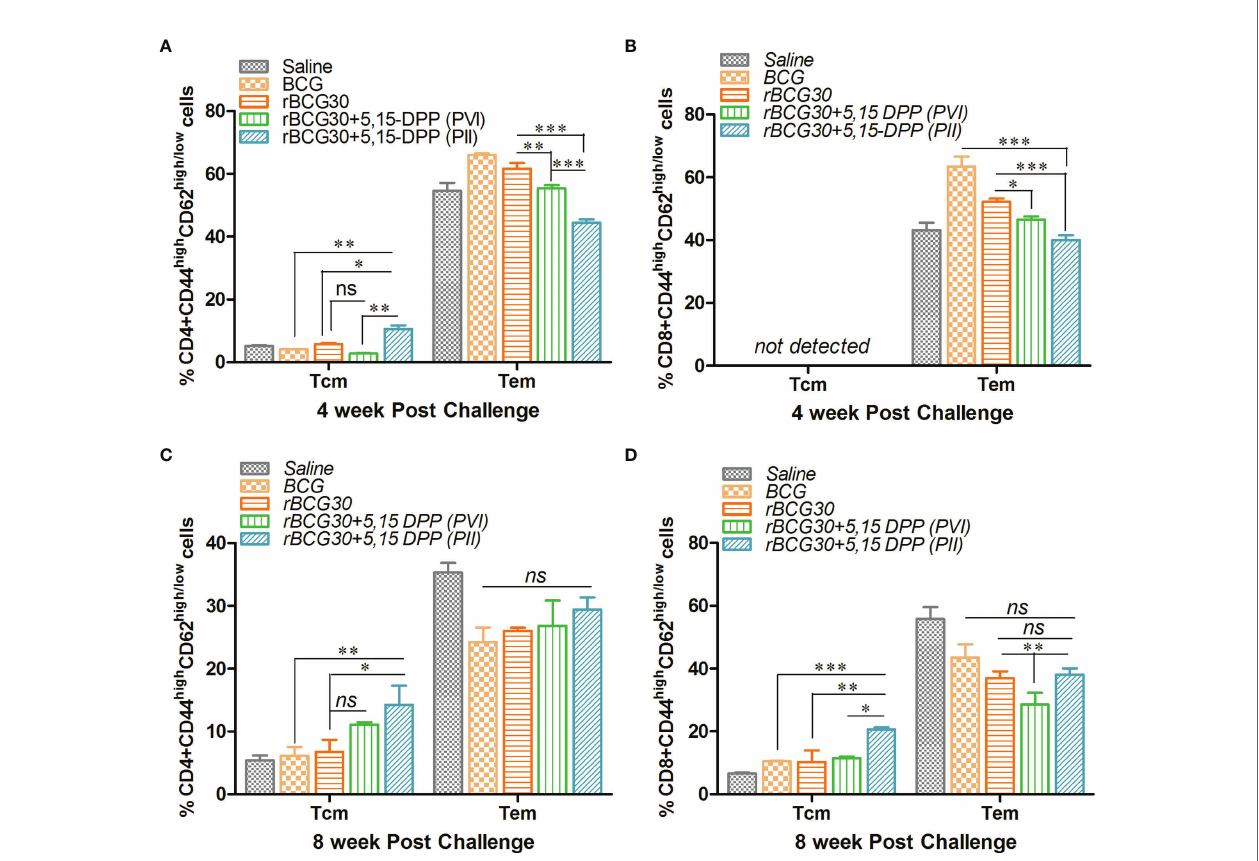
FIGURE 8 | Evaluation of T cells memory response at 4 and 8 weeks post-challenge. Antigen-speci fi c CD4+ and CD8+ T central and effector memory response was assessed in splenocytes isolated from various groups of mice at both 4 and 8 weeks PC. The bar graphs in the fi gure depict the comparative magnitude (in percent) of T effector (Tem) (CD44 high CD62L low ) and T central (Tcm) (CD44 high CD62L high ) cells among (A, C) CD4+, and (B, D) CD8+ memory T cells at 4 (upper panel) as well as 8 (lower panel) weeks PC, respectively. The data were analyzed by employing two-way ANOVA followed by Bonferroni ’ s multiple comparison test and are shown as means ( ± SEM) from one of the two independent experiments with similar observations performed in at least three biological replicates, where p<0.05(*), p<0.01(**), and p<0.001(***) were considered signi fi cant. ns, non-signi fi